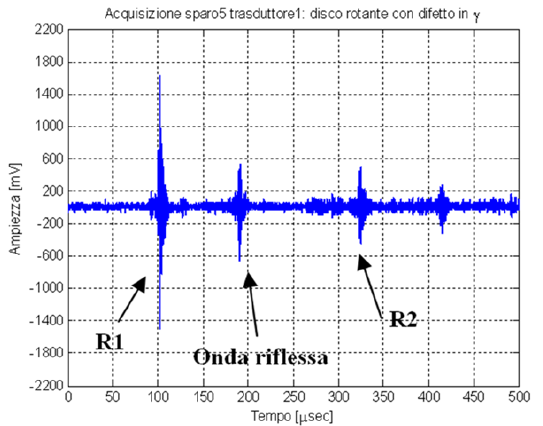
Figura 6: Segnale acquisito dal trasduttore 1. Disco rotante con difetto in γ =-70°. Figure 6: Signal acquired by transducer 1. Rotating disk with defect at γ =-70°.